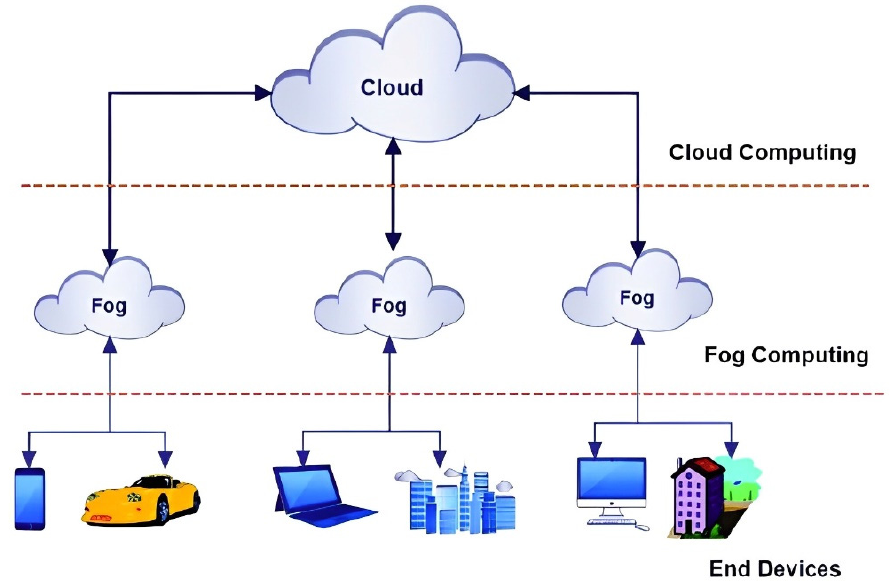
Figure 4. In fog computing, the cloud is brought closer to end user devices